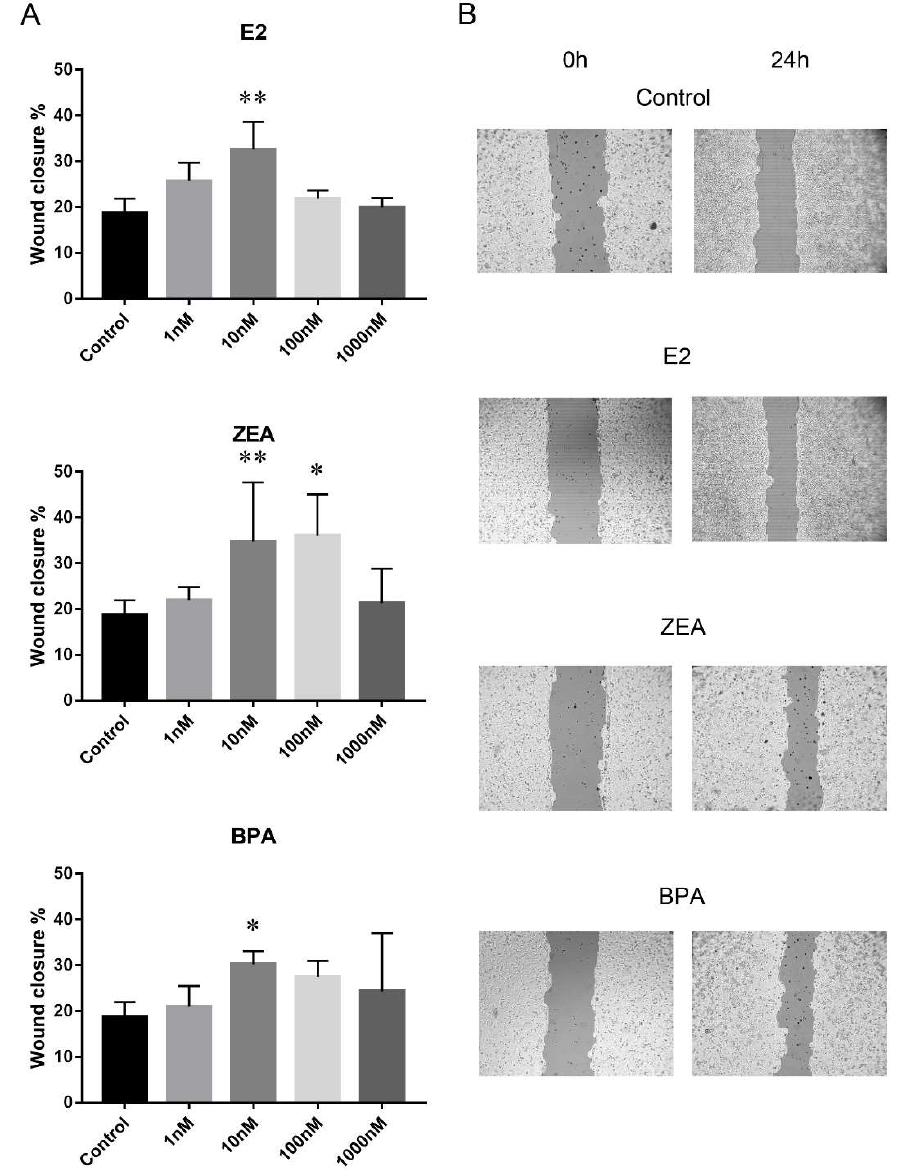
Figure 2. Effect of E2, ZEA and BPA on the migration of the PEO1 cell line. ( A ) Migration rate in response to the addition of 1, 10, 100, 1000 nM E2, ZEA and BPA. Migration rate was determined by scratch assay. Open wound area was determined at the time of scratching (0 h) and 24 h later. Wound closure % indicates migration rate. Data are presented as mean ± S.D. Significance was determined relative to the non-treated control: * p < 0.05; ** p < 0.01. ( B ) Representative result of a scratch assay experiment after the addition of 10 nM E2, ZEA and BPA. The output of the TScrach software is presented. Magnification: ×10.